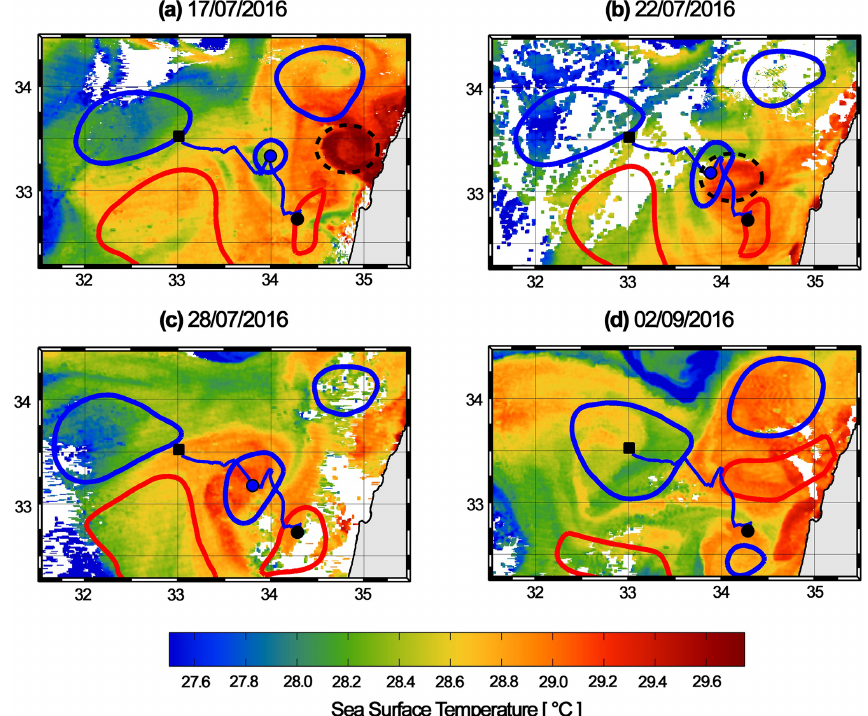
Figure 9. Daily snapshots of SST images showing a quickly moving warm-core anticyclone, part of a dipole that detaches from the Levantine coast and merges with a future Eratosthenes anticyclone. Superimposed DYNED contours are blue for anticyclones and red for cyclones. The track of the studied anticyclone is shown in blue line, its current center is shown using a blue circle, its initial detection on 10 February 2016 is shown using a black circle and its last detection on 2 September 2016 is shown using a black square. A blue line approximates the track of the warm-core anticyclone as seen in the SST sequence.